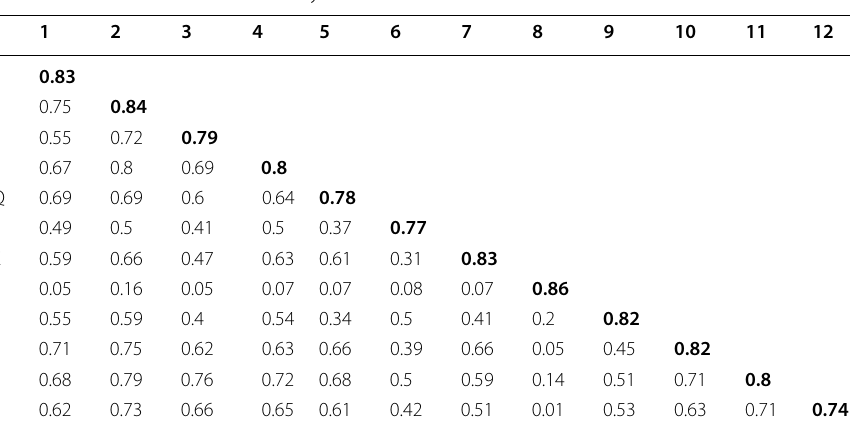
Table 3 Criteria for discriminant validity